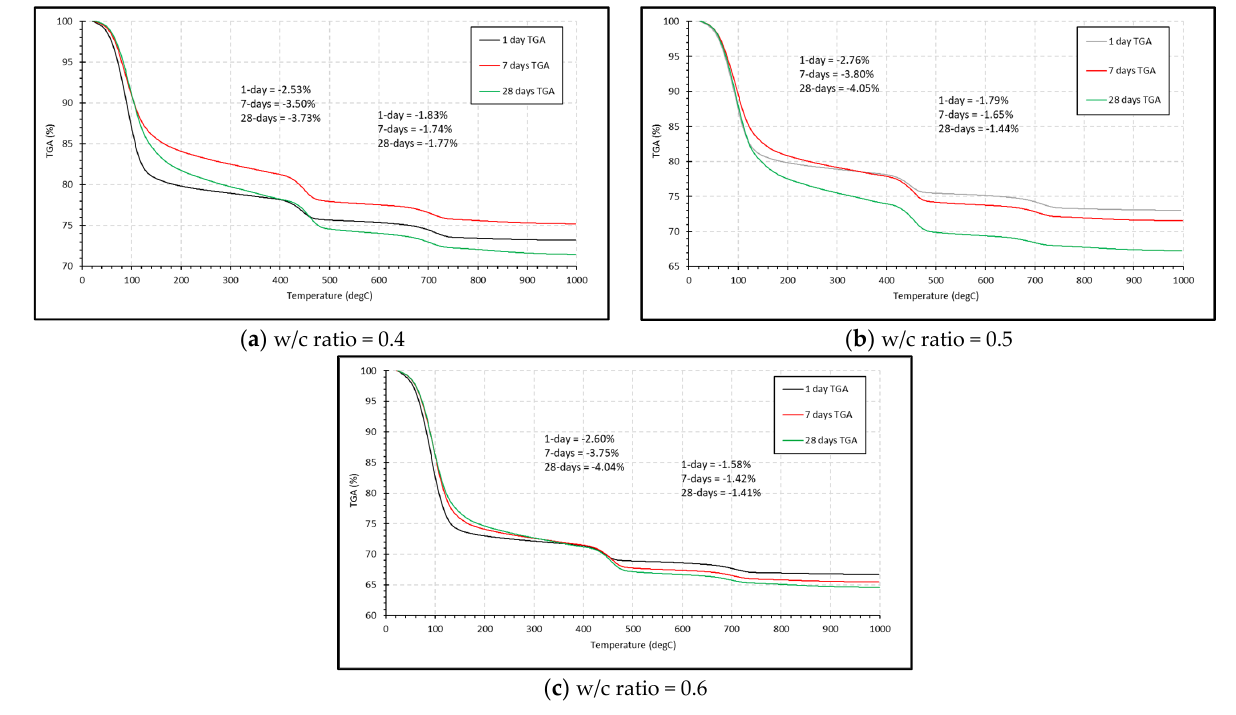
Figure 4. Mass change by TGA at 1, 7 and 28